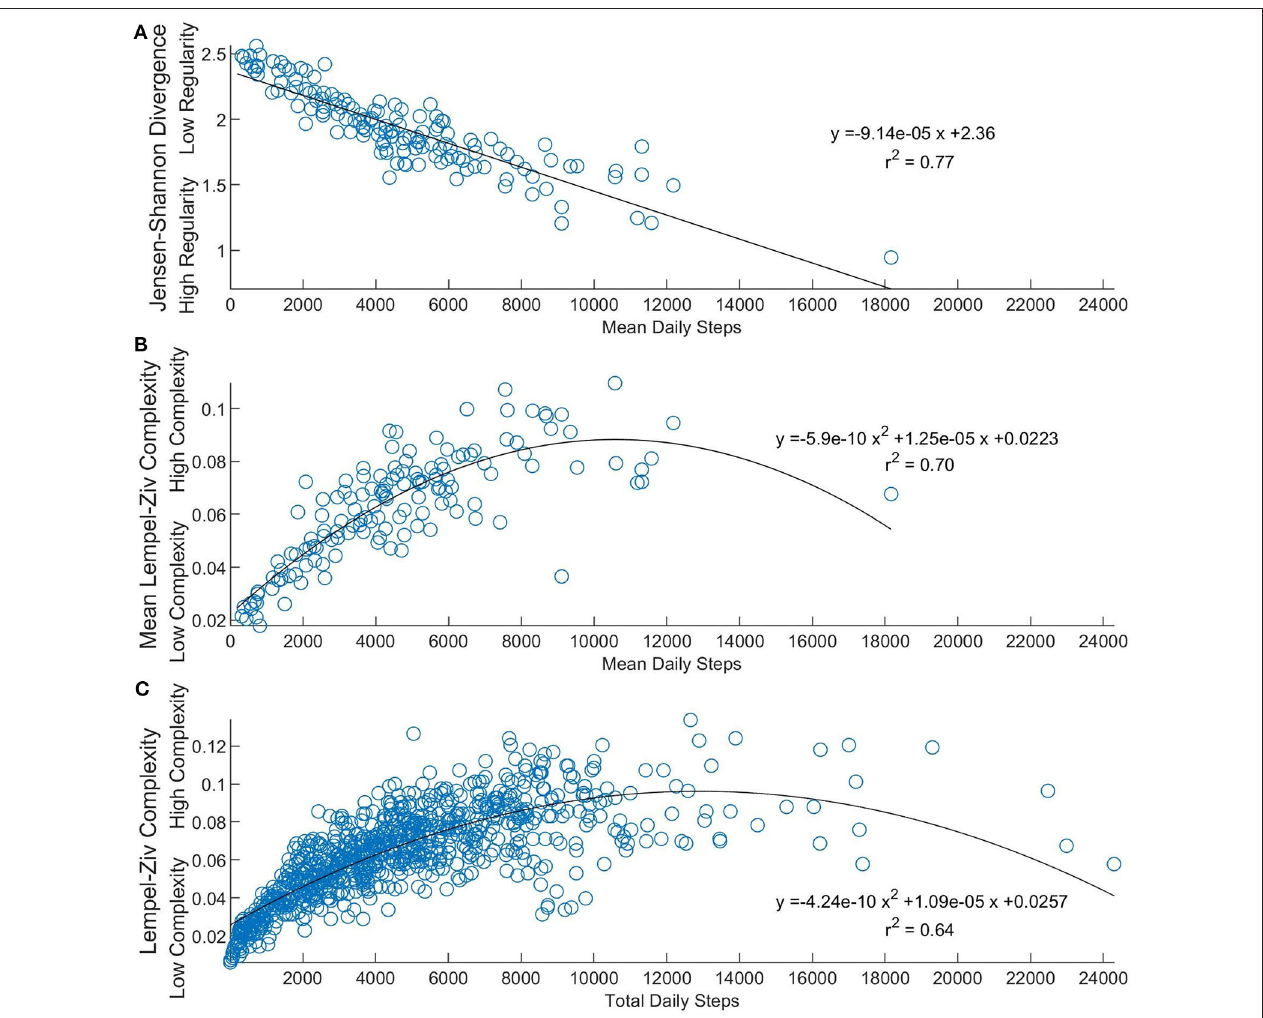
FIGURE 2 | Relating linear and nonlinear physical activity measures. (A) Shows the relationship between JSD values and mean daily steps over 6 days ( n = 142). Lesser JSD values represent more similarity in physical activity patterns across days. (B) Compares participants’ average activity complexity value to their mean daily steps value ( n = 142). (C) Shows the relationship between daily LZC values and total daily steps ( n = 852). Lesser LZC values represent less complex physical activity patterns.